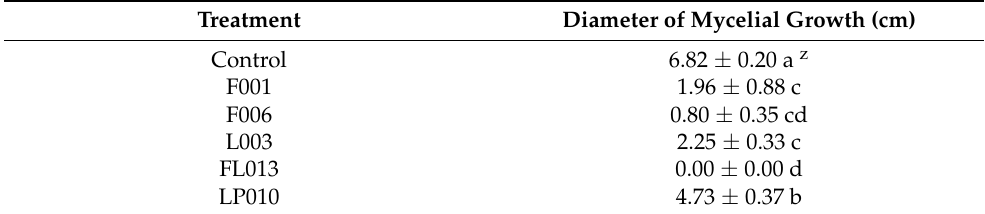
Table 2. Antagonistic effects of yeast suspension on mycelial growth of C. gloeosporioides in agar well tests after seven days incubation at 28 ± 2 ◦ C.